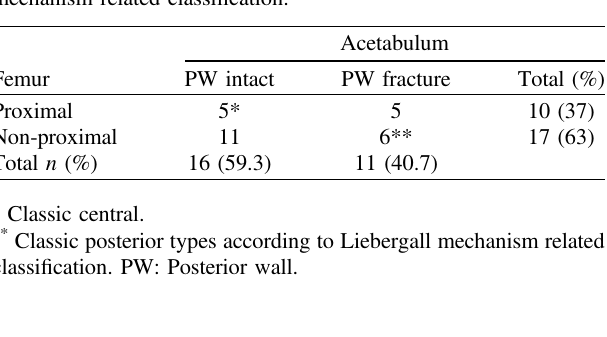
Table 4. Distribution of fracture patterns according to Liebergall ’ s mechanism related classi fi